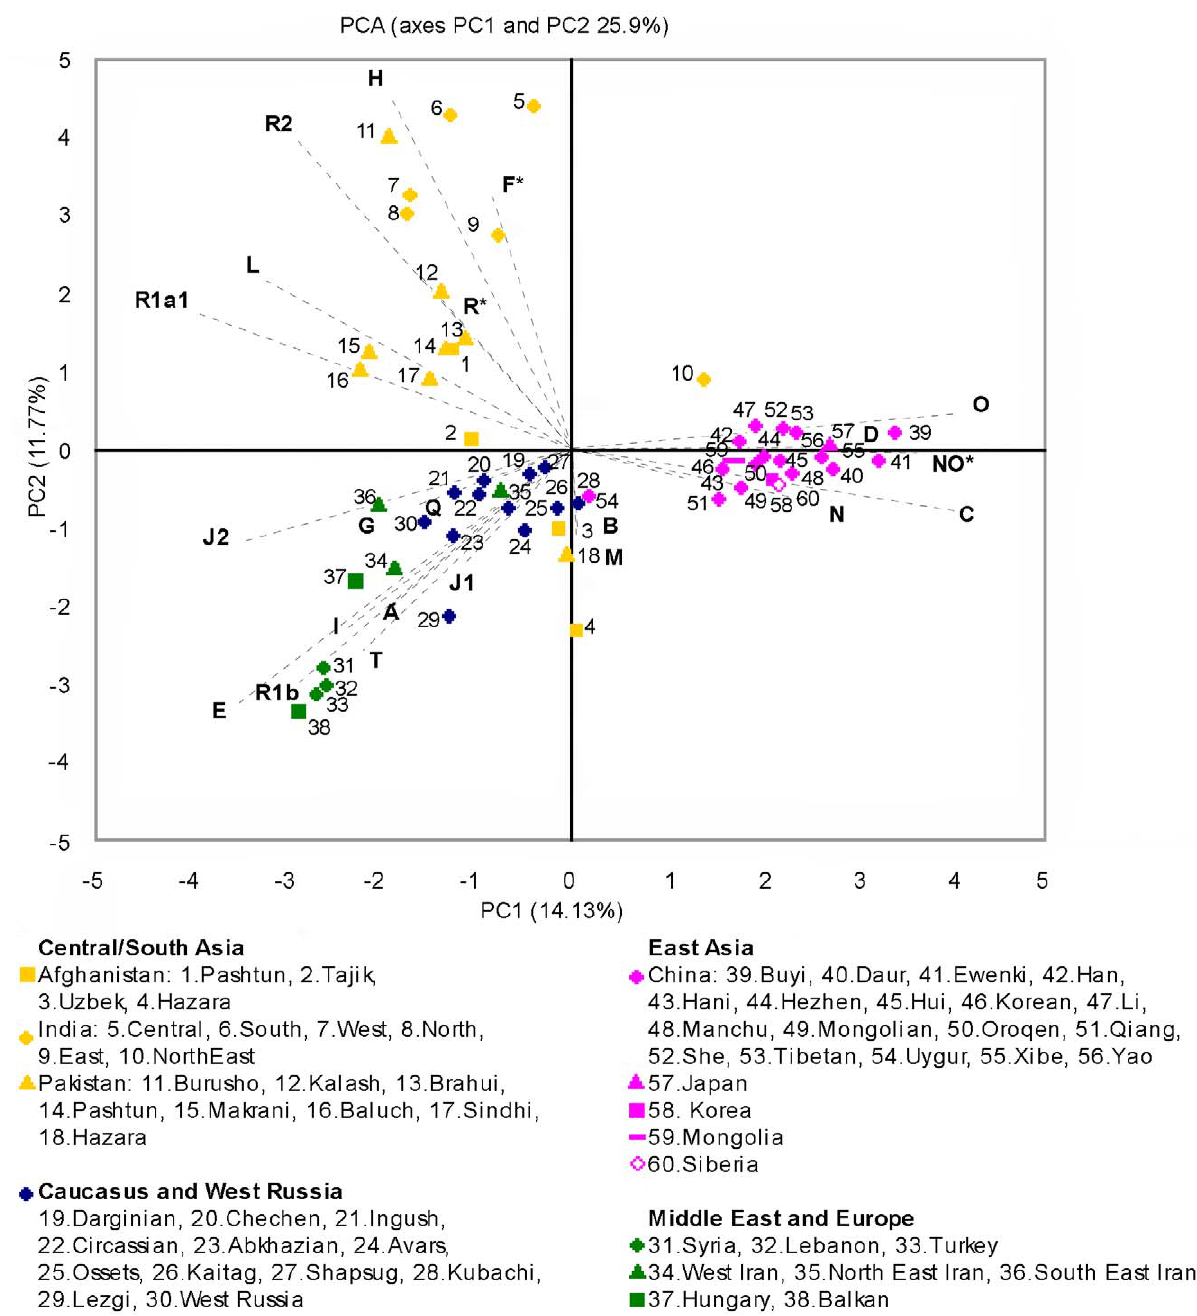
Figure 1. PCA derived from Y-chromosomal haplogroup frequencies. The two leading principal components display the variance. The superimposed biplot shows the contribution of each haplogroup as grey component loading vectors.